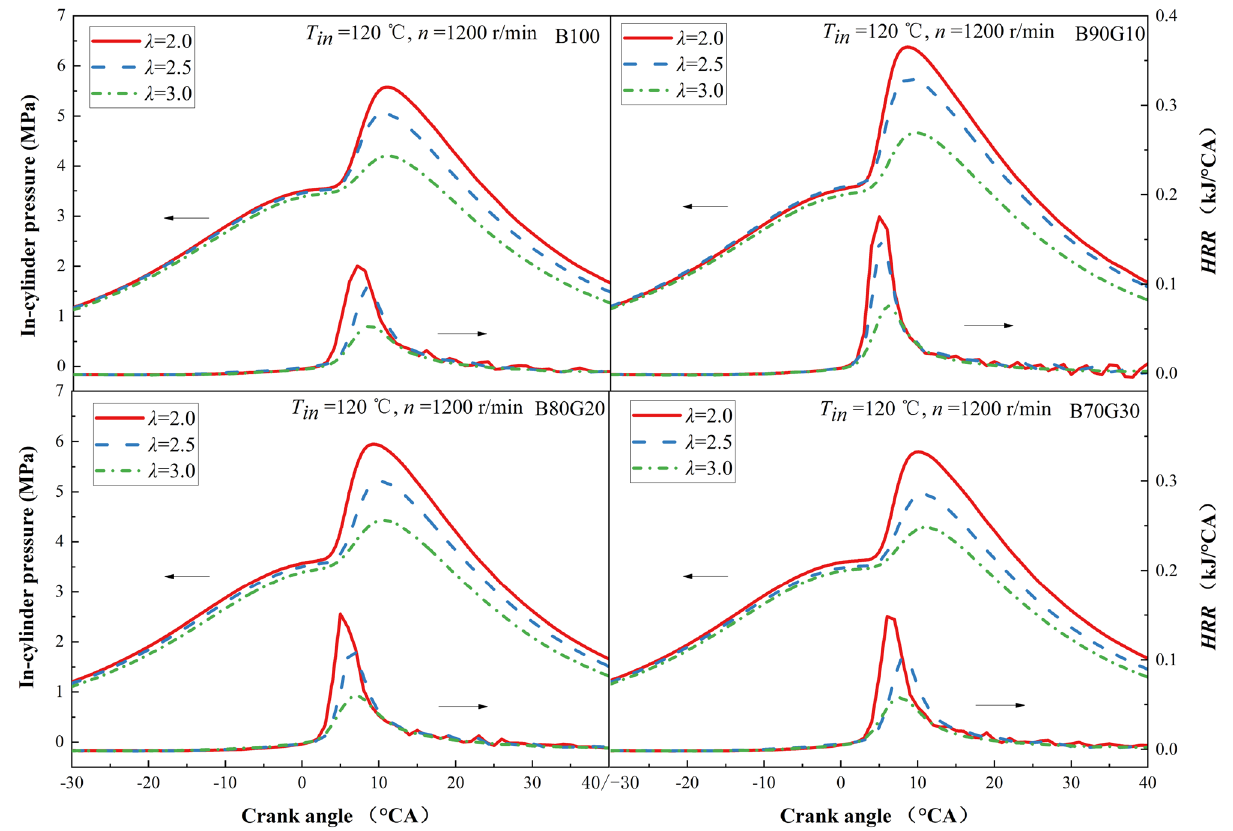
Figure 2. In-cylinder pressure and HRR with different λ